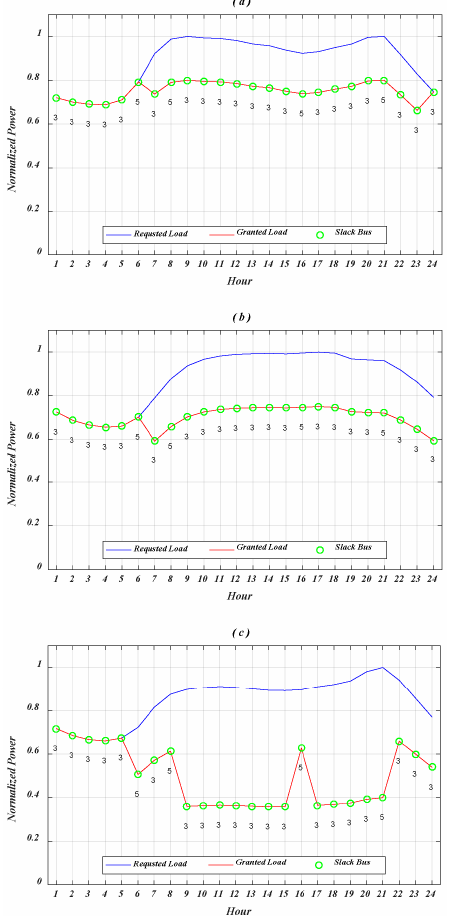
Figure 4. Normalized requested demand, and the power granted for 24 h when MGs located at L1 for: ( a ) Area 1; ( b ) Area 2 and ( c ) Area 3.